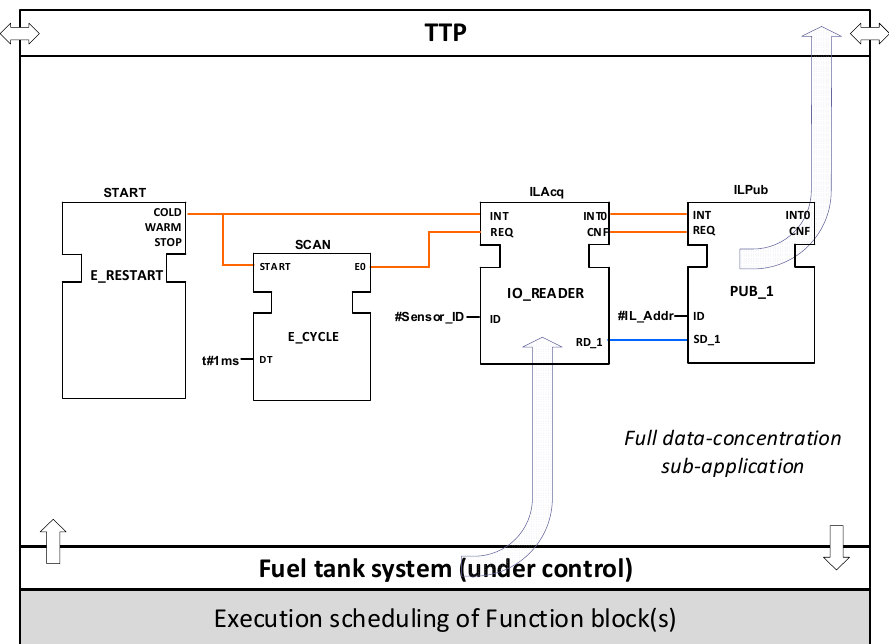
Figure 10. Reassure I.A from CPIOM-Sensing device for scenario 1 and 2.